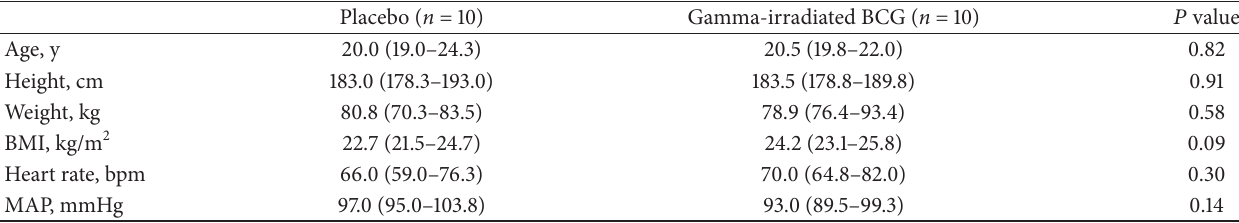
Table 1: Baseline characteristics.